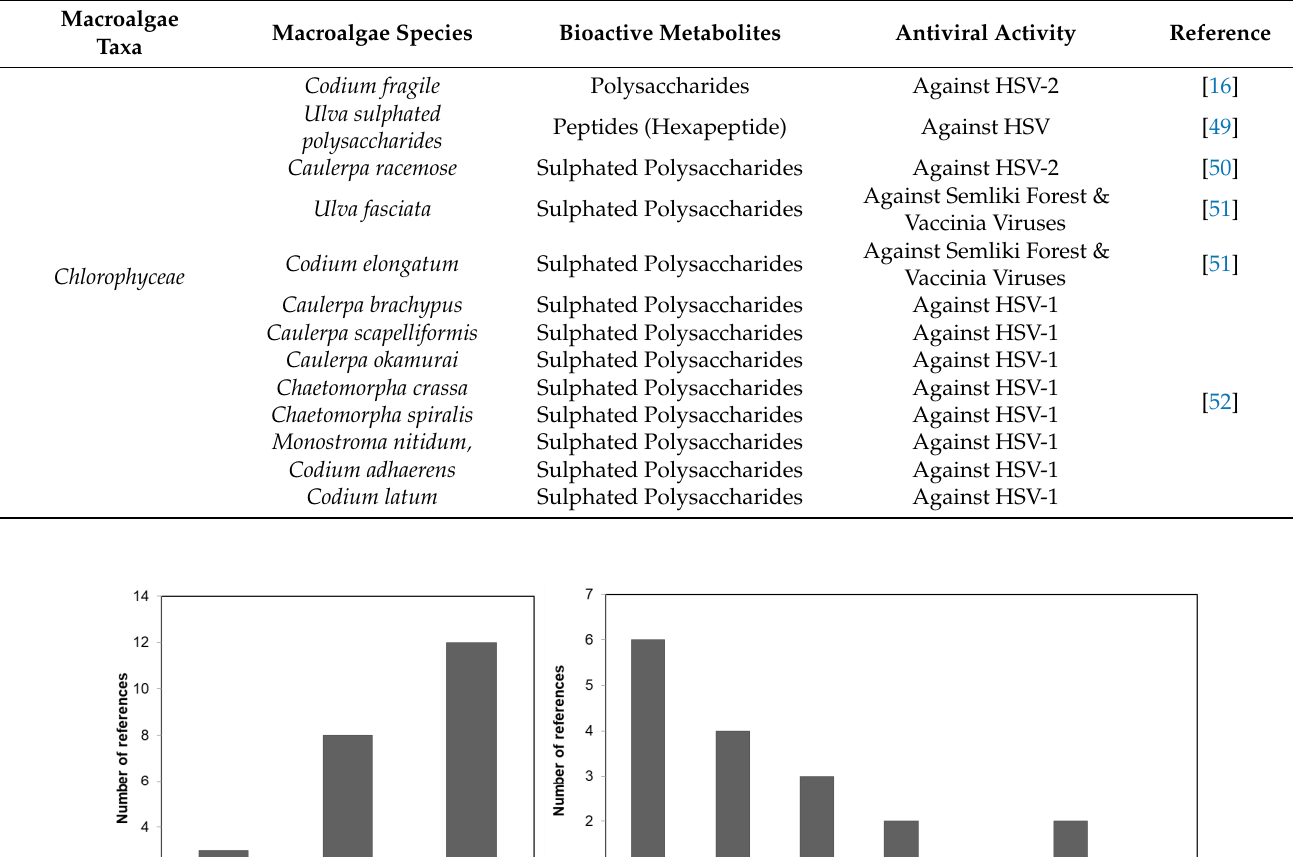
Table 3. A review of antiviral activity of macroalgae— Chlorophyceae .